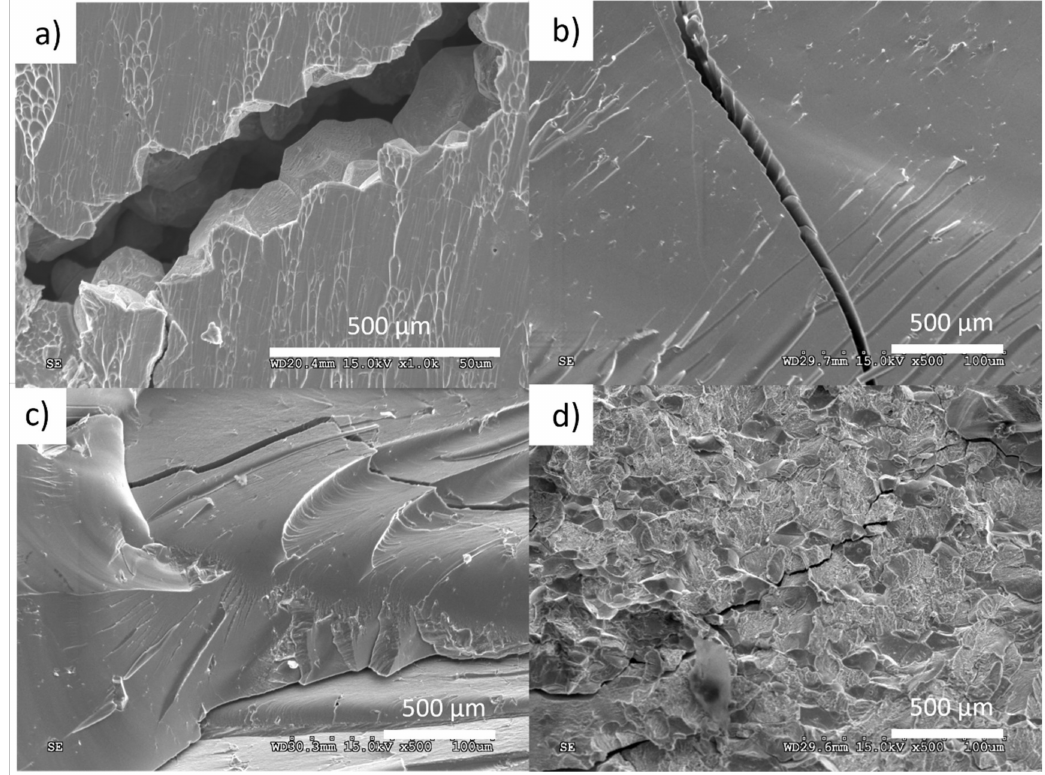
Figure 13. Fractography of sintered samples ( a ) 420 ◦ C/480 s ( b ) 440 ◦ C/480 s ( c ) 440 ◦ C/60 s ( d ) 460 ◦ C/60